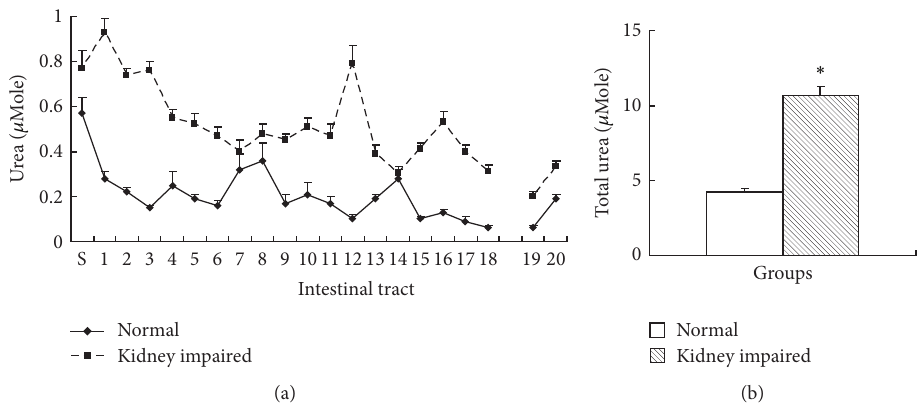
Figure 5: BUN in intestinal tract (mean ± SE, 𝑛 = 10 ). There were 20 segments of intestinal tract except cecum, and the content of BUN was expressed as 𝜇 Mole (molar concentration multiplying volume) per segment. BUN in every segment of intestinal tract in kidney impaired group was higher than that in normal group (a), and the total BUN in intestinal tract in kidney impaired group was also higher than that in normal group (b). Rats in kidney impaired group were intragastrically treated with adenine (400 mg/kg × 5 days), while those in normal group were treated with normal saline of the same volume. S, stomach; 1 to 18 at horizontal ordinate meant the 1st to 18th segment of small intestinal tract; 19 and 20 meant 2 segments of colon. ∗ versus normal group, 𝑃 < 0.05 , Student’s 𝑡 -test.